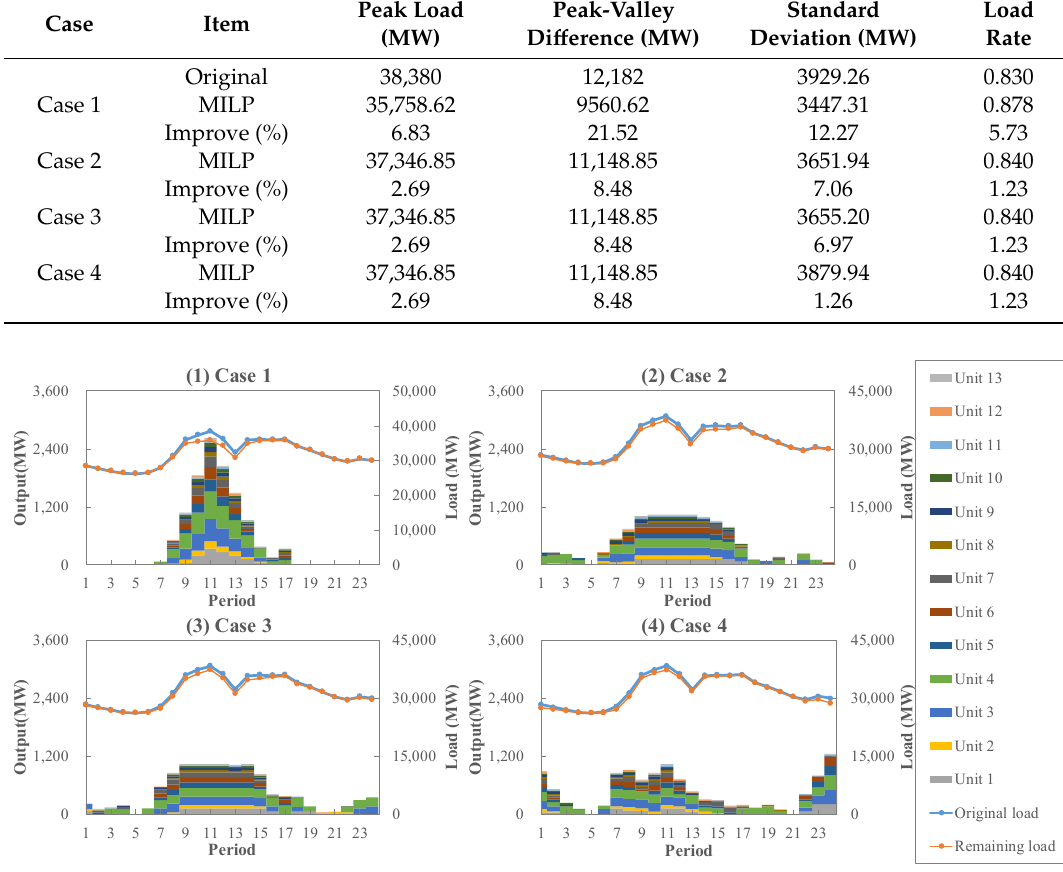
Figure 6. Scheduling results of the MILP model in Case 2.